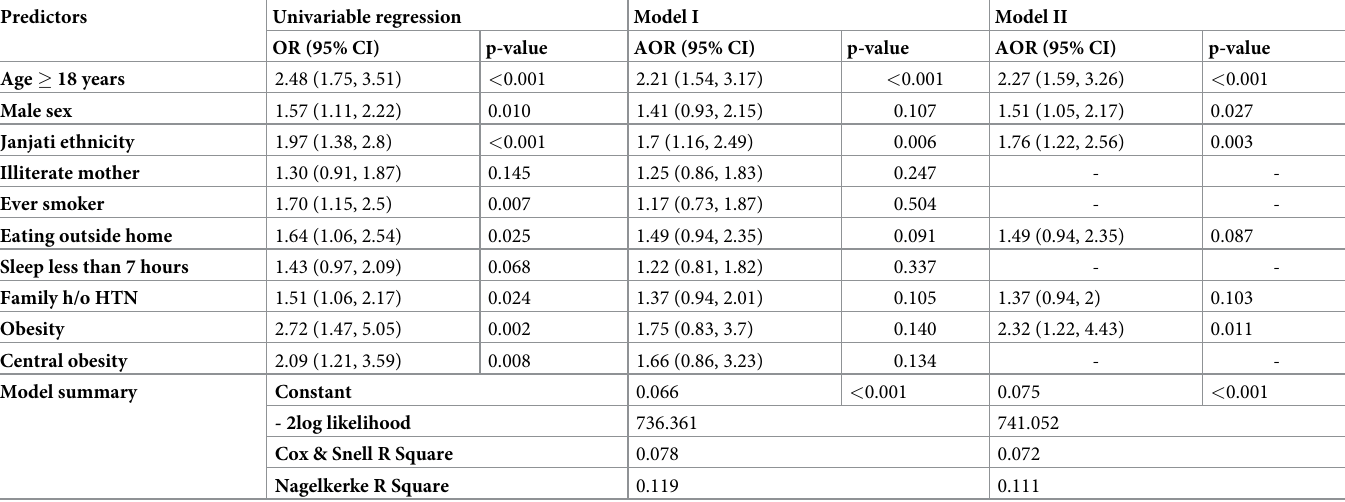
Table 5. Univariable and multivariable regression analysis of predictors of prehypertension (n = 749).